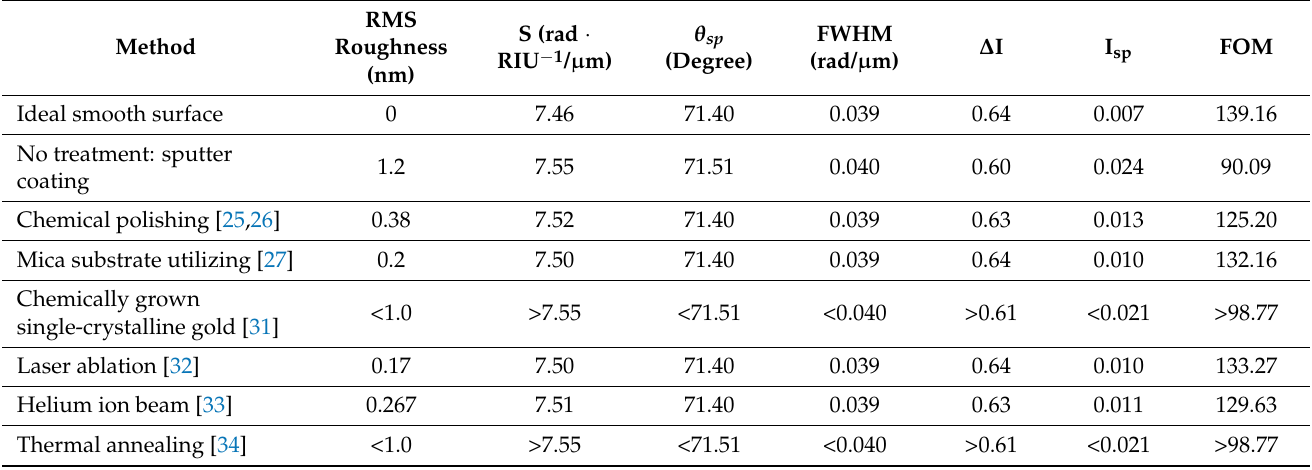
Table 2. Refractive index sensing parameters for different surface roughness and smoothing